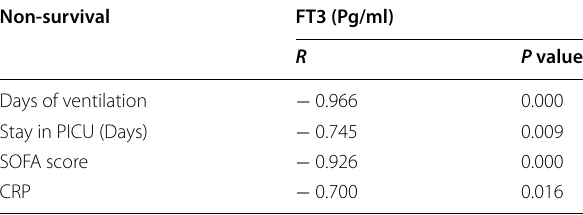
Table 7 Correlations between FT3 in day 5 of illness regards days of ventilation, days of stay in PICU, SOFA score, CRP